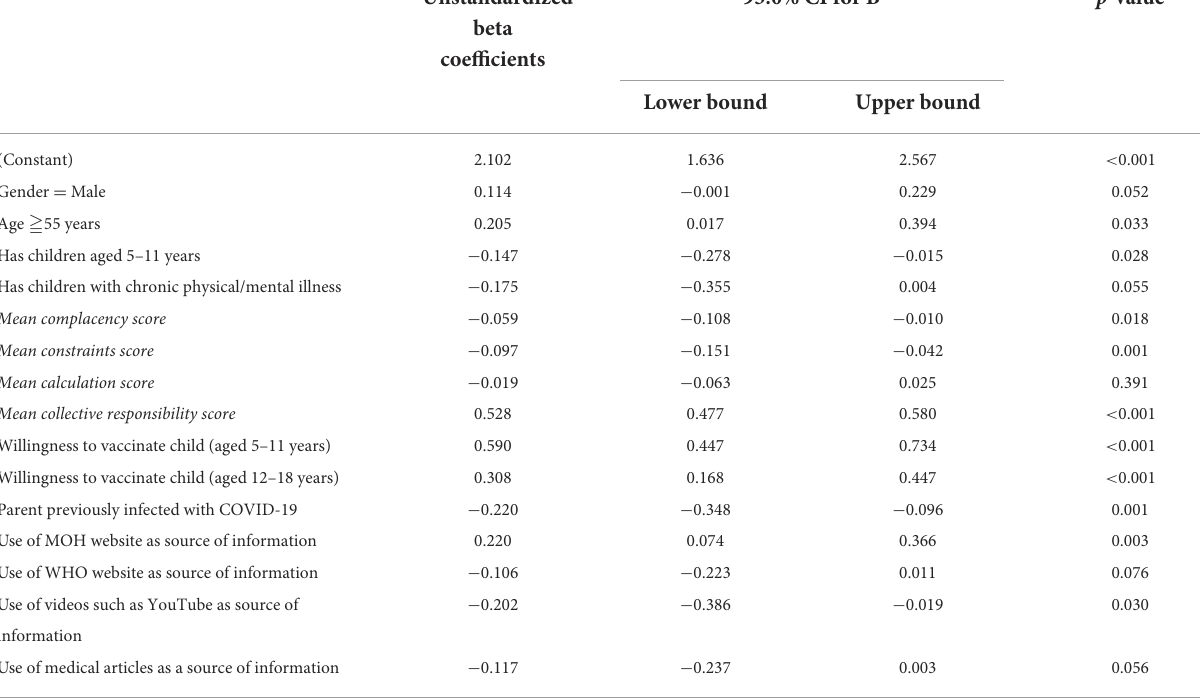
TABLE 1 Multivariate linear regression analysis of parents’ confidence as scored by the 5C